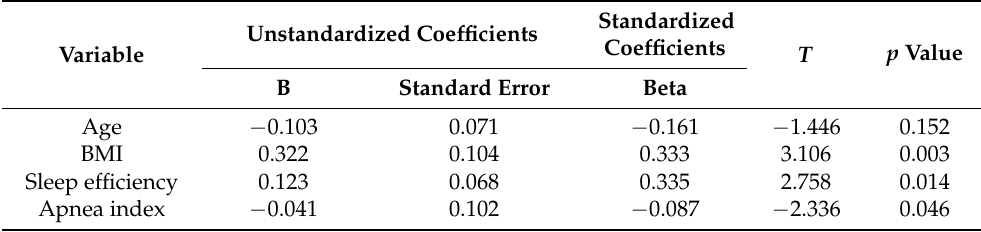
Table 3. Result of multiple linear regression analysis of the contribution of other variables on cognitive